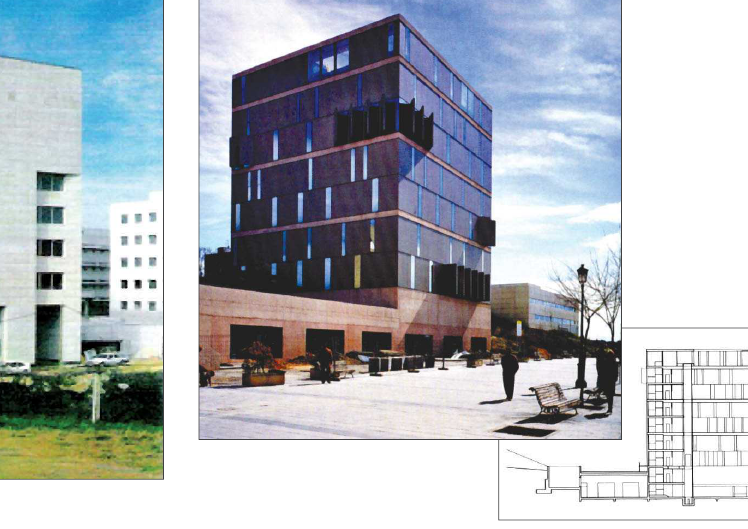
2 pav. Useros viešoji biblioteka Madride (2005 m.) Fig 2. Usera Public Library in Madrid (2005)